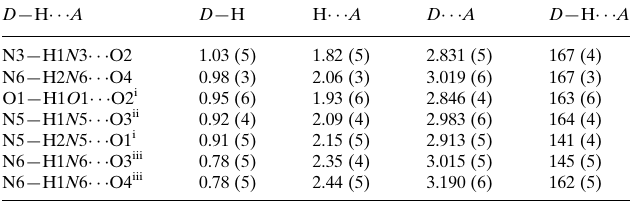
Hydrogen-bond geometry (A˚ , (cid:5)